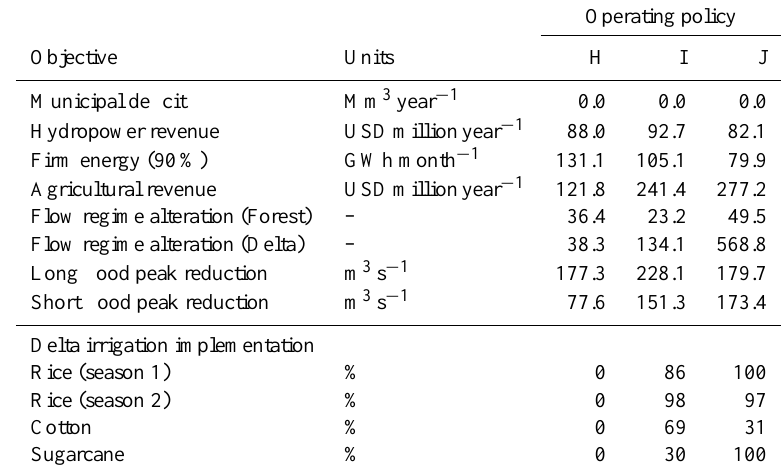
Table 1. Objective values and irrigation scheme implementation percentages for selected operating policies from Fig. 12.